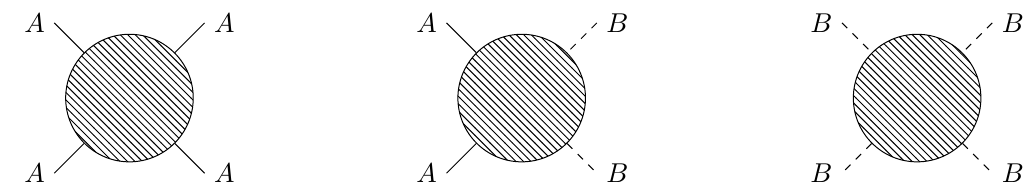
Figure 1 . The complete system of scattering amplitudes of the Z 2 odd particle A with mass m and the massless dilaton B